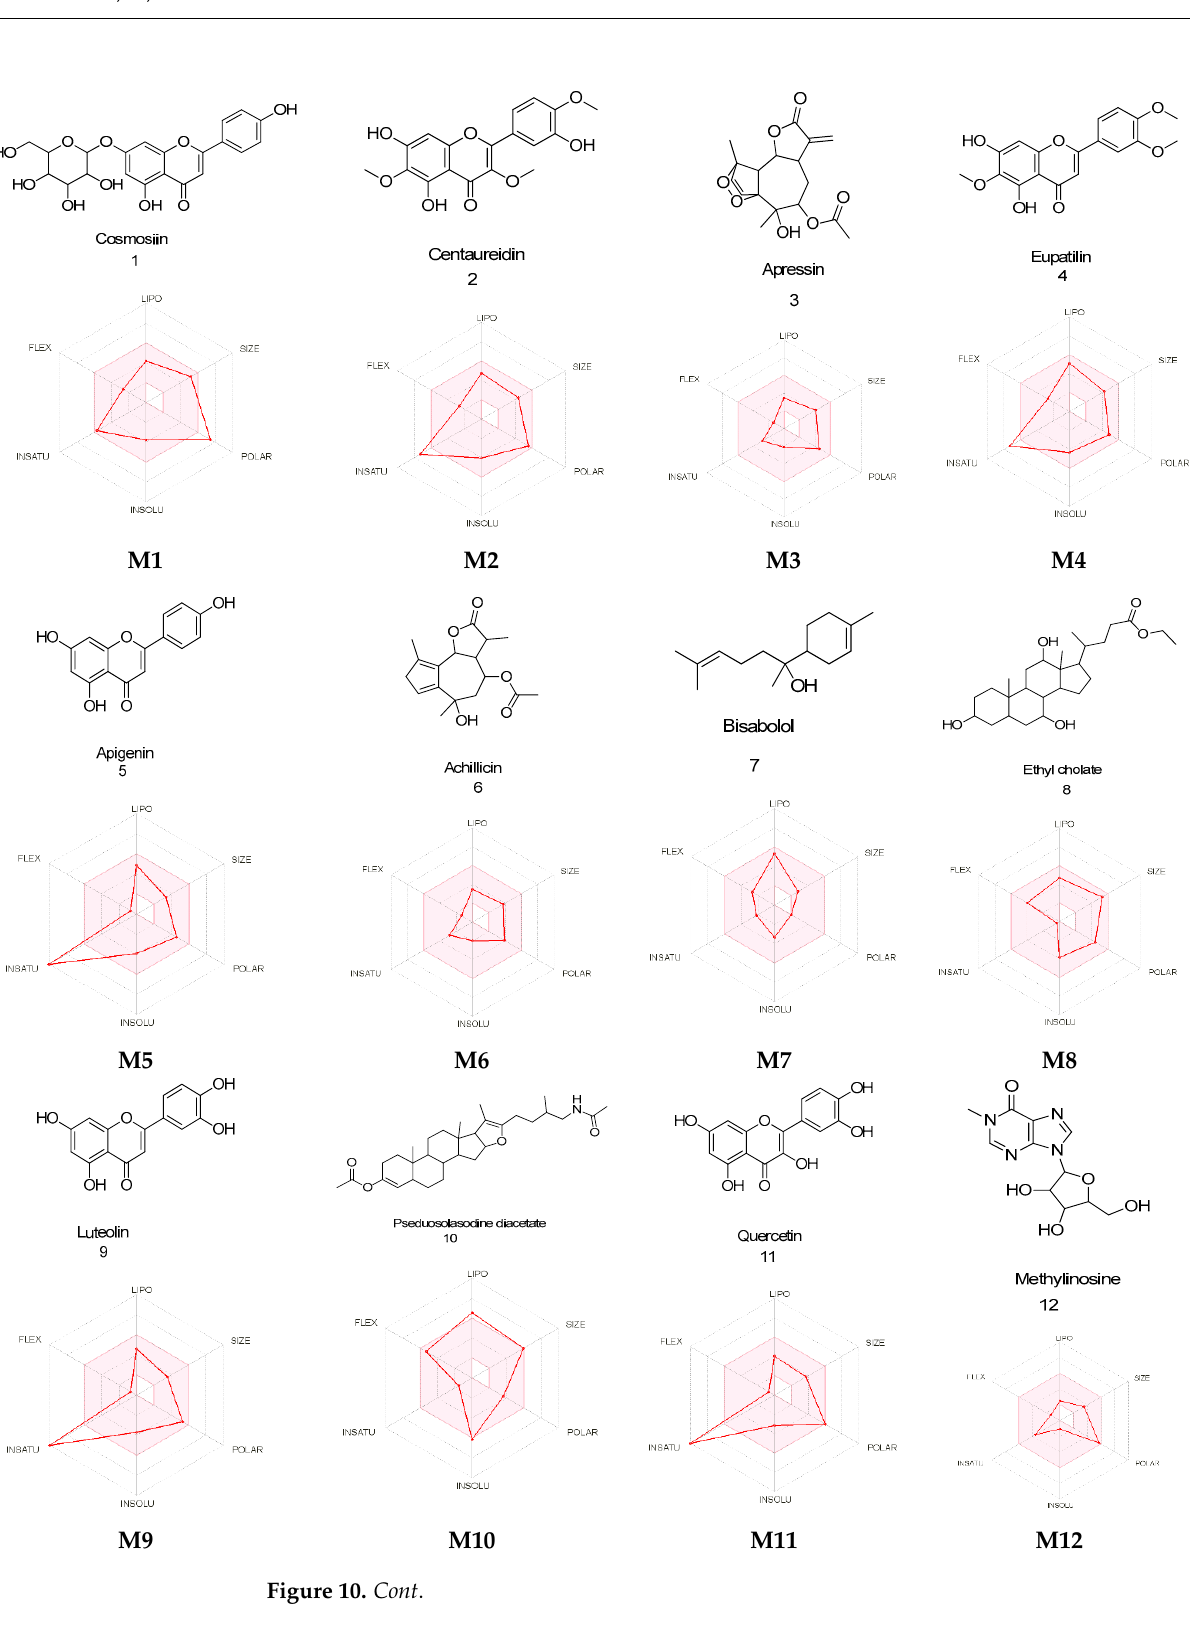
M14 Figure 10. Radar diagrammatic representation of A. fragrantissima flower dichloromethane extract- derived identified metabolites ( M1 – M14 ) using SwissADME webserver. LIPO: Lipophilicity, Size: Molecular weight, POLAR: solubility, INSOLU: insolubility, INSATU: insaturation, and FLEX: flexibility. The properties involved in the colored zone are preferred for orally active drugs.